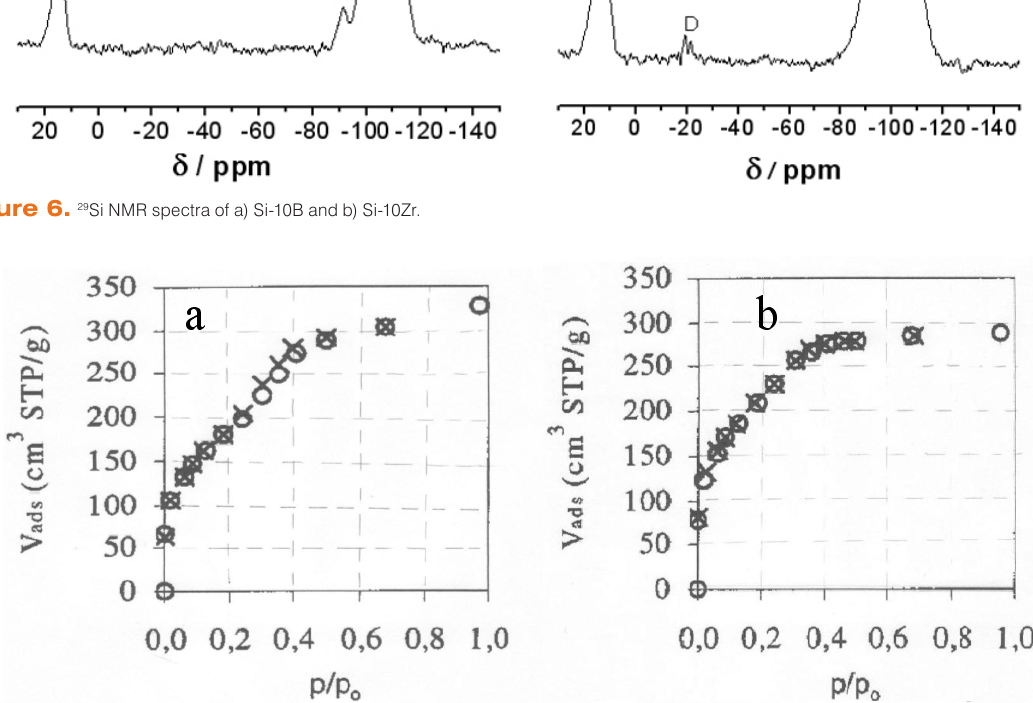
Figure 7. Low temperature nitrogen adsorption isotherm on a)Si-10B and